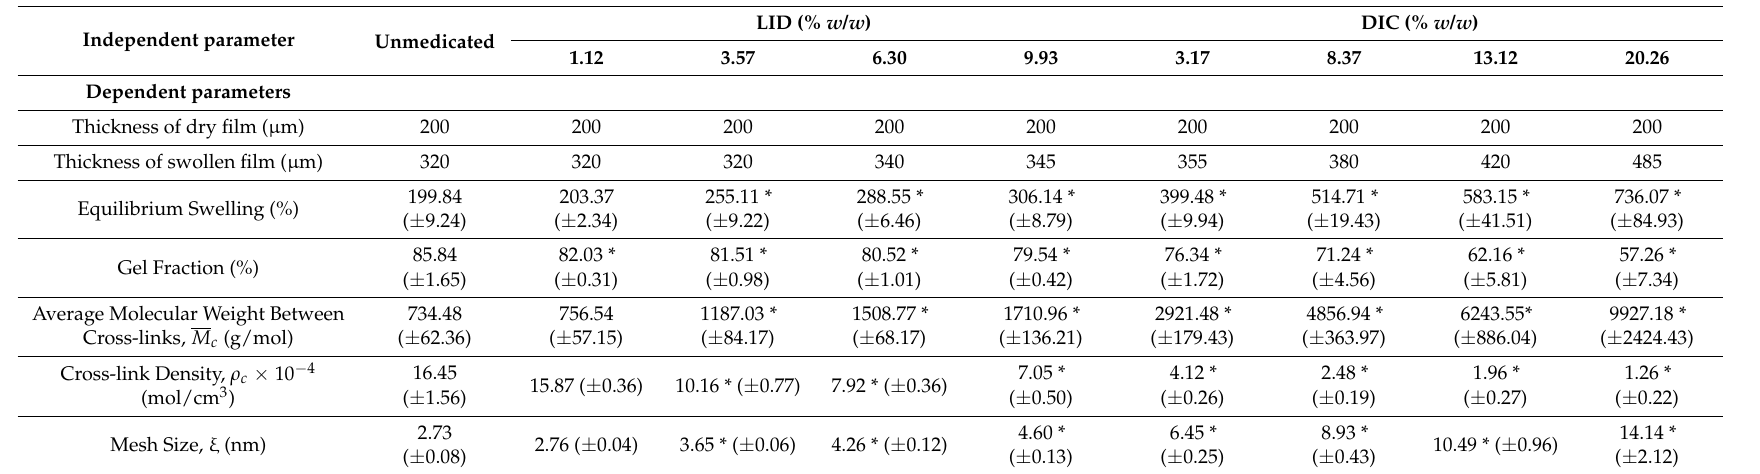
Table 3. Effect of drug physicochemical properties on the dependent variables involved in the swelling studies of in situ loaded PEO hydrogel films. Values in brackets indicate the standard deviation from the reported mean. ( n = 4, * Significantly different from unmedicated hydrogel; p <